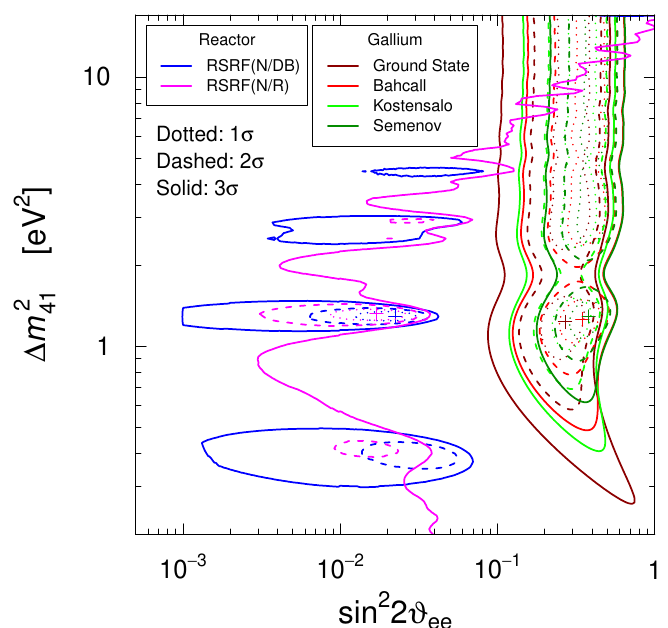
Figure 4. Contours delimiting the 1 σ , 2 σ , and 3 σ allowed regions in the ( sin 2 2 ϑ ee , ∆ m 2 obtained from the Gallium data with different cross sections compared with those obtained from the two analyses of reactor spectral ratio data discussed in the text. The best-fit points are indicated by